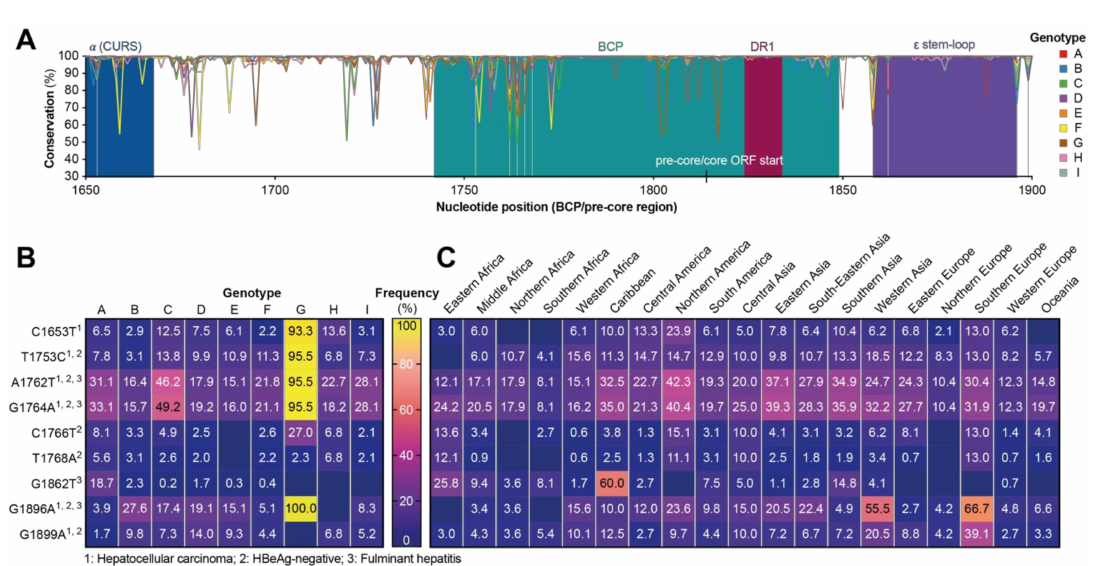
Figure 5. Frequency of clinically relevant mutations in basal core promoter or pre-core region of HBV. ( A ) Conservation of basal core promoter (BCP) and pre-core region of the HBV genome, vertical gray lines indicate positions as which clinically relevant mutations occur. Numbering according to convention starting at EcoRI site. α CURS = α core upstream regulatory sequence. ( B , C ) Frequency of clinically relevant mutations in the BCP / pre-core region within ( B ) each genotype or ( C ) the di ff erent world regions. Numbers in the table indicate percentage of sequences containing the respective mutation. Blue fields without numbers represent a value of 0.0%. Superscript numbers indicate the clinical finding, which has been associated with the respective